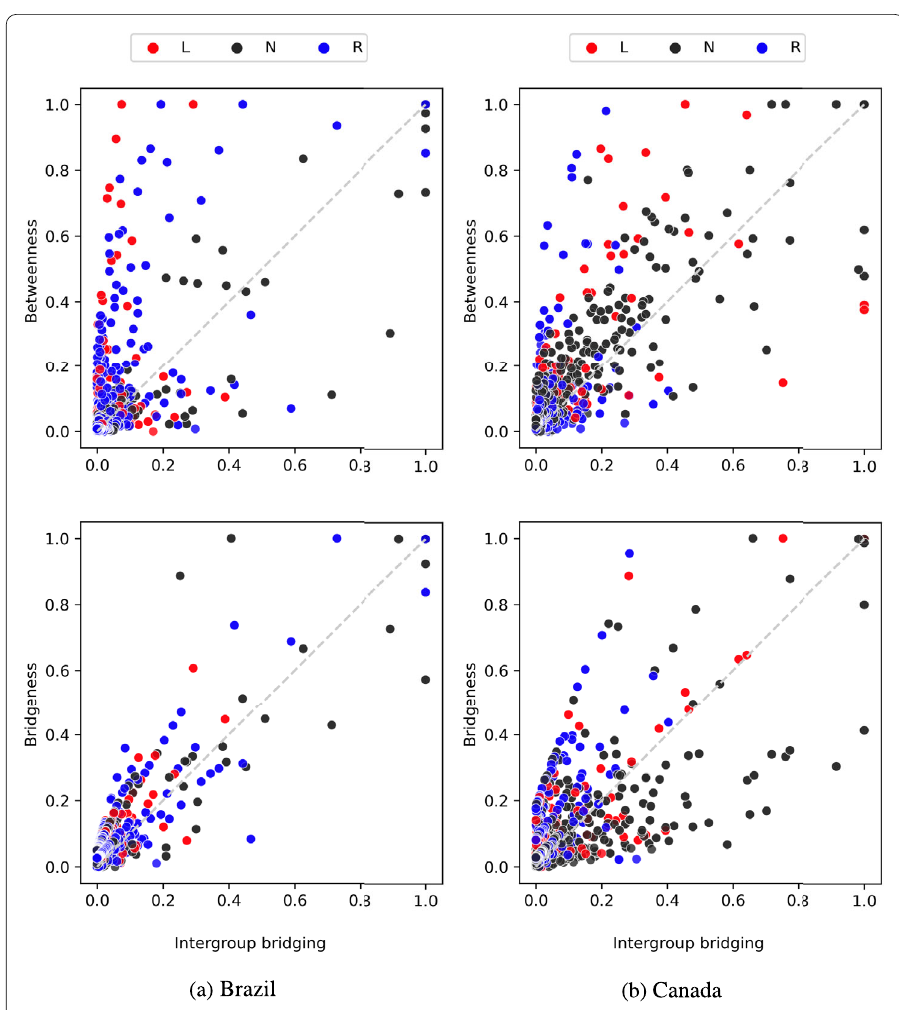
Figure 6 Comparison between centrality metrics in all weeks, with top 100 users according to intergroup bridging and the top 100 users according to betweenness or